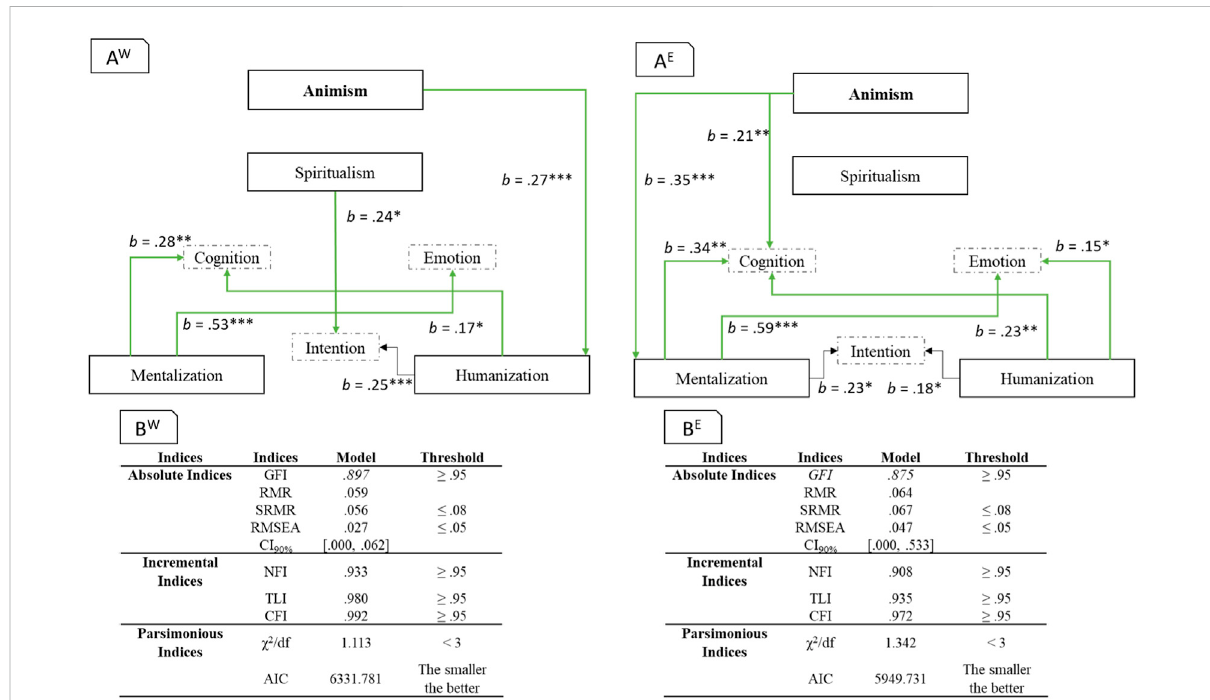
FIGURE 6 Panel (A) .Pathmodelwithstandardizedcoef fi cient.*: p < 0.05,**: p < 0.01,***: p < 0.001.Onlythesigni fi cantpathsarepresentedwiththeWest sampleontheleft(A W )andtheEastAsiansampleontheright(A E ).Panel (B) .Pathmodel fi tindicespresentedwiththeWestsampleontheleft(B W )and the East Asian sample on the right (B E